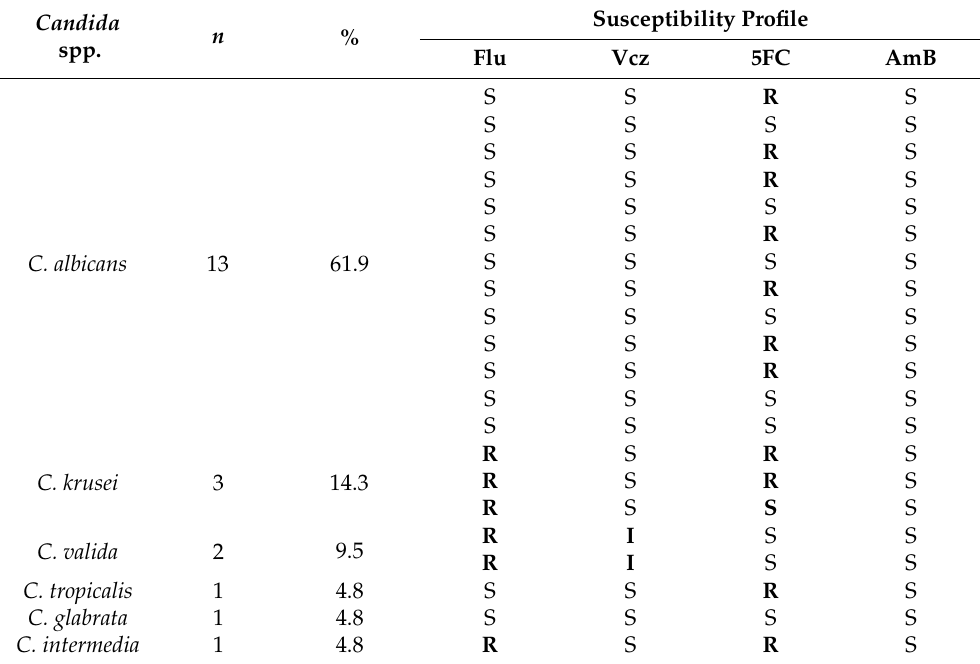
Table 3. Total number and percentage, identification of the collected oral Candida spp. isolates.